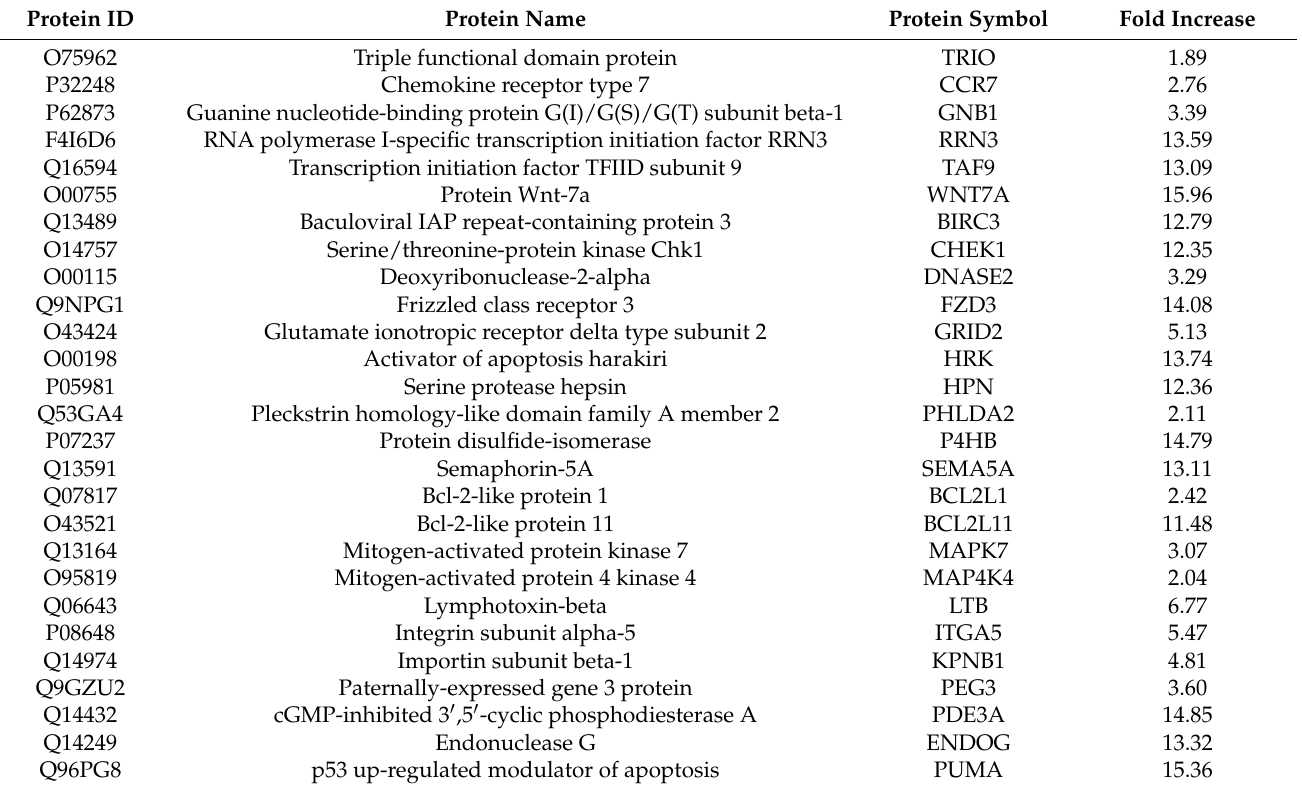
Figure 7. Andrographolide induces apoptosis of GC cells. AGS-EBV and AGS cell lines were treated either with DMSO, NaB, andrographolide, or a combination of andrographolide and NaB. The apoptotic cells were analyzed by flow cytometry. ( A ) Apoptosis in AGS-EBV cells; ( B ) apoptosis in AGS cells; ( C ) comparison of percentages of apoptotic cells in AGS-EBV and AGS cell lines. Staurosporine was used as a positive control for cell apoptosis. ***: p < 0.001. Table 3. List of apoptosis-associated proteins up-regulated in andrographolide-treated cells.